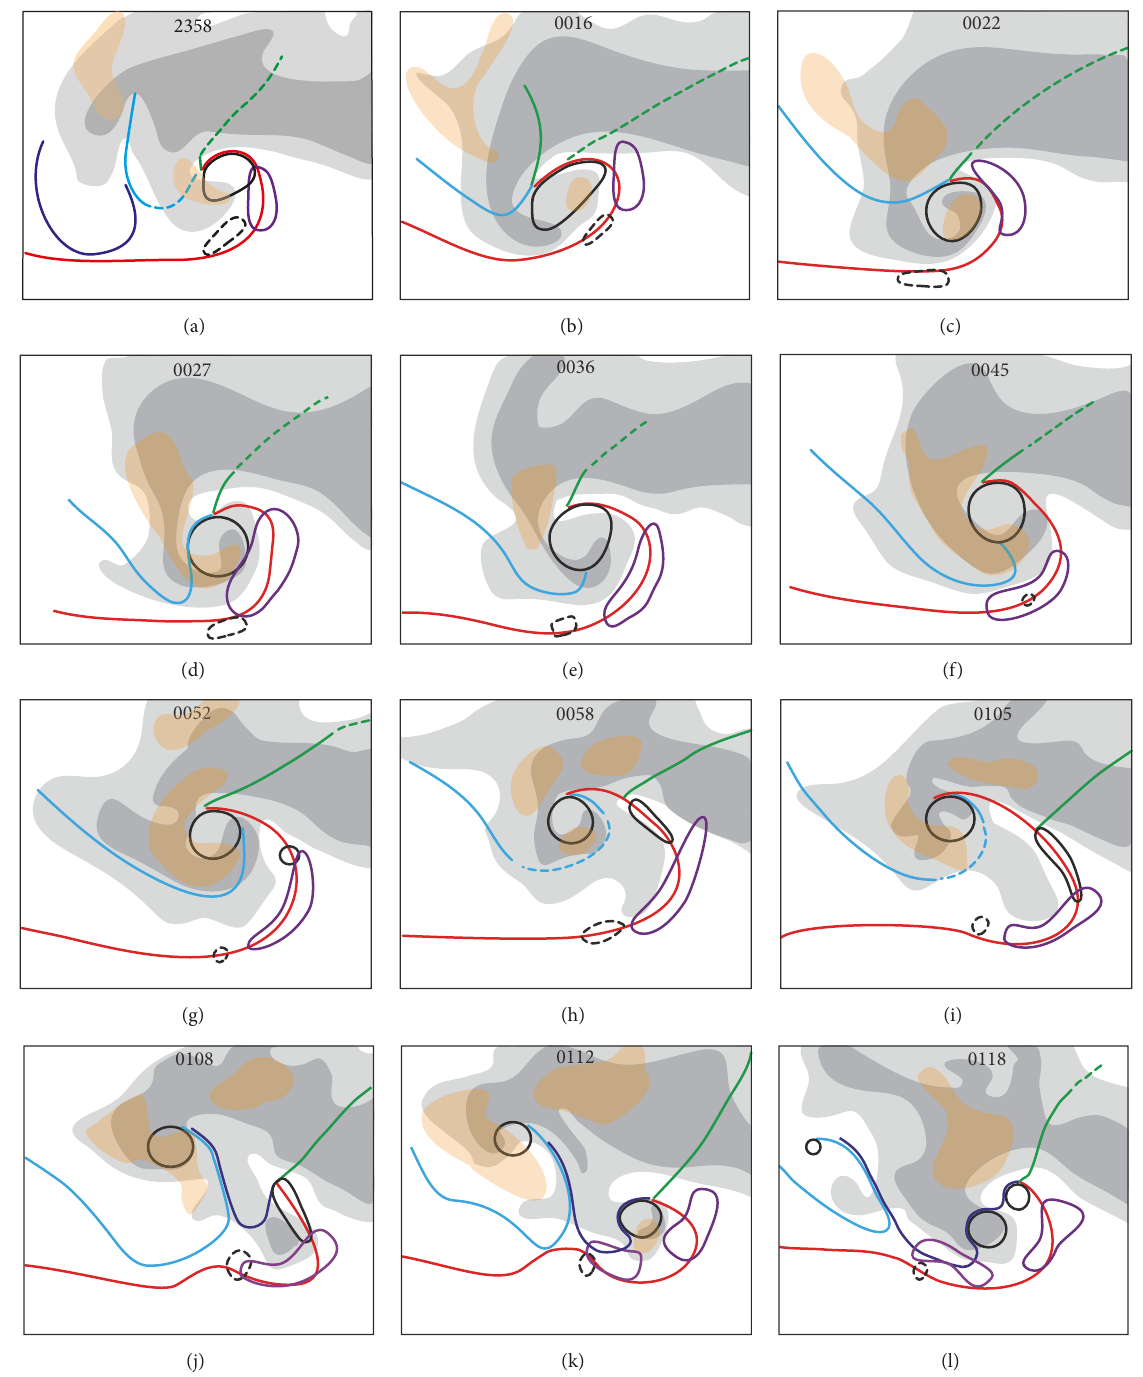
Figure 14: Near-surface boundaries are outlined in solid colors: red is the primary RFGF, green is the FFCB, light blue is the SRFGF, and dark blue is the new SRFGF. The near-surface mesocyclones are indicated in black ovals; the midlevel updraft shear region vorticity is indicated by purple ovals. Reflectivity was shaded grey at 40 and dark gray at 50 dBZ, and downdraft stronger than -5m s −1 at an altitude of 2 km is shaded in